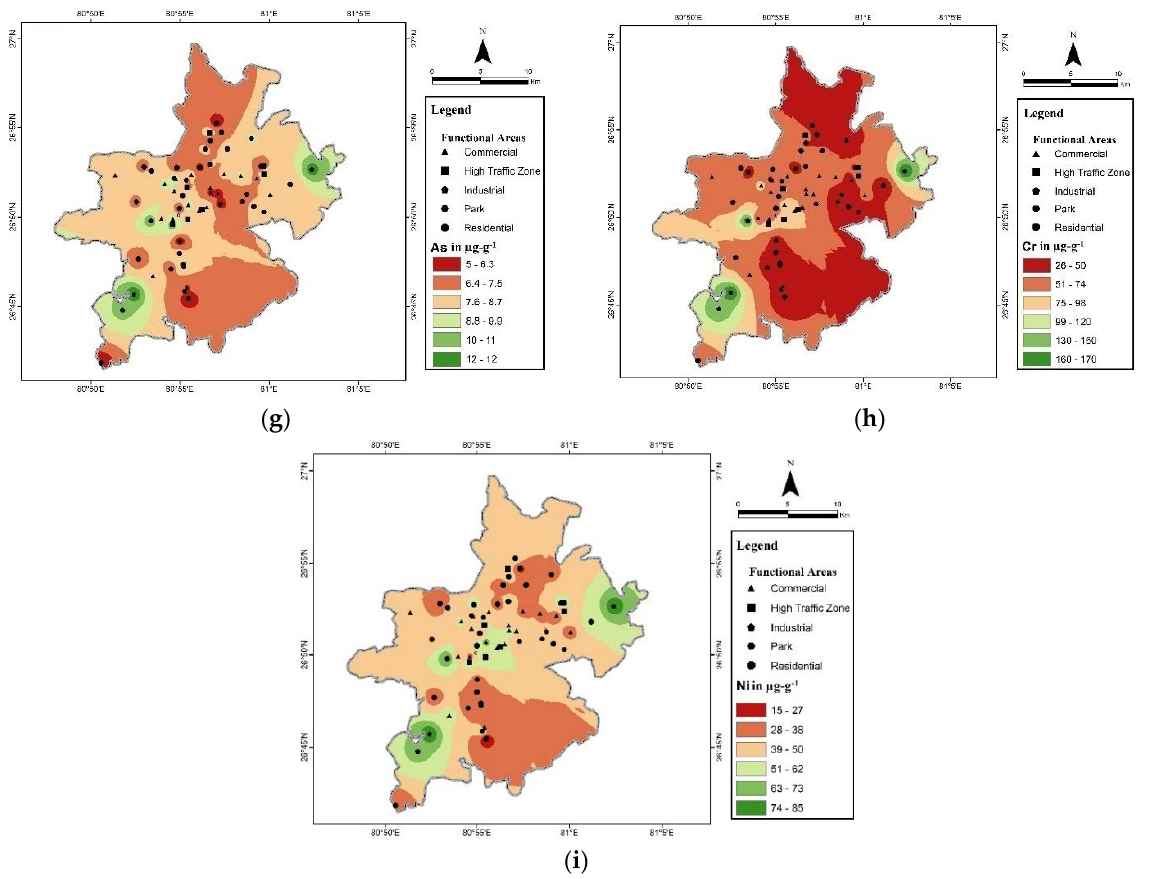
Figure 4. ( a–i ) Spatial distribution of HMs in the road dust of Lucknow over different functional areas.